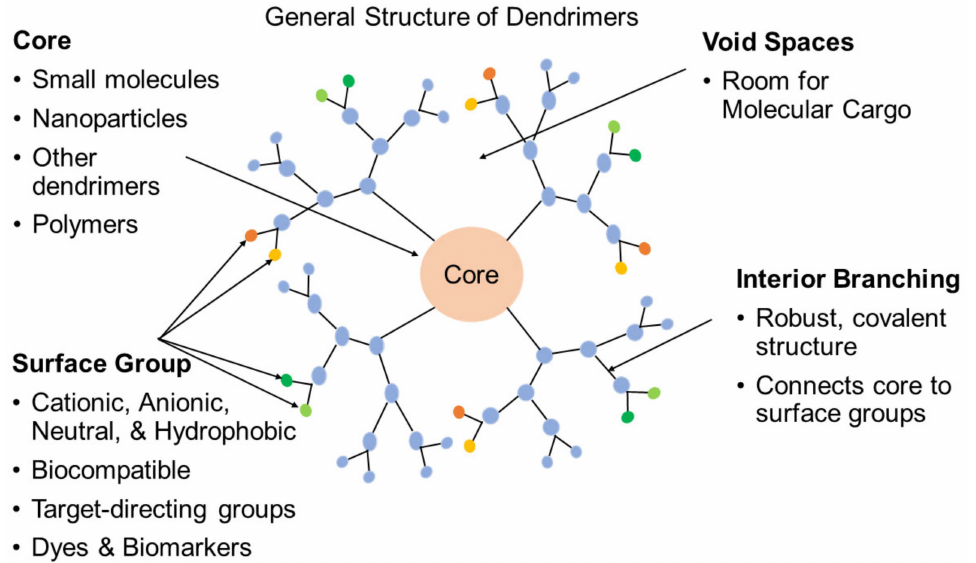
Figure 3. Schematic diagram of the general structure of dendrimers. The architecture is comprised of core and interior branching radiating out in layers. The drug of interest can be filled into the void space and/or connected onto the surface (adapted from Pharmaceutical Technology , 2008